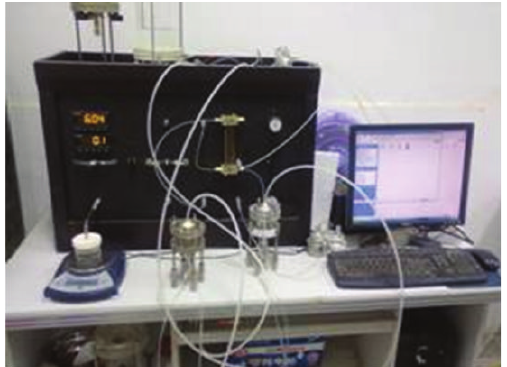
Figure 5: Outlet and evaporation correction bottle. Figure 6: Servo flow permeameter.